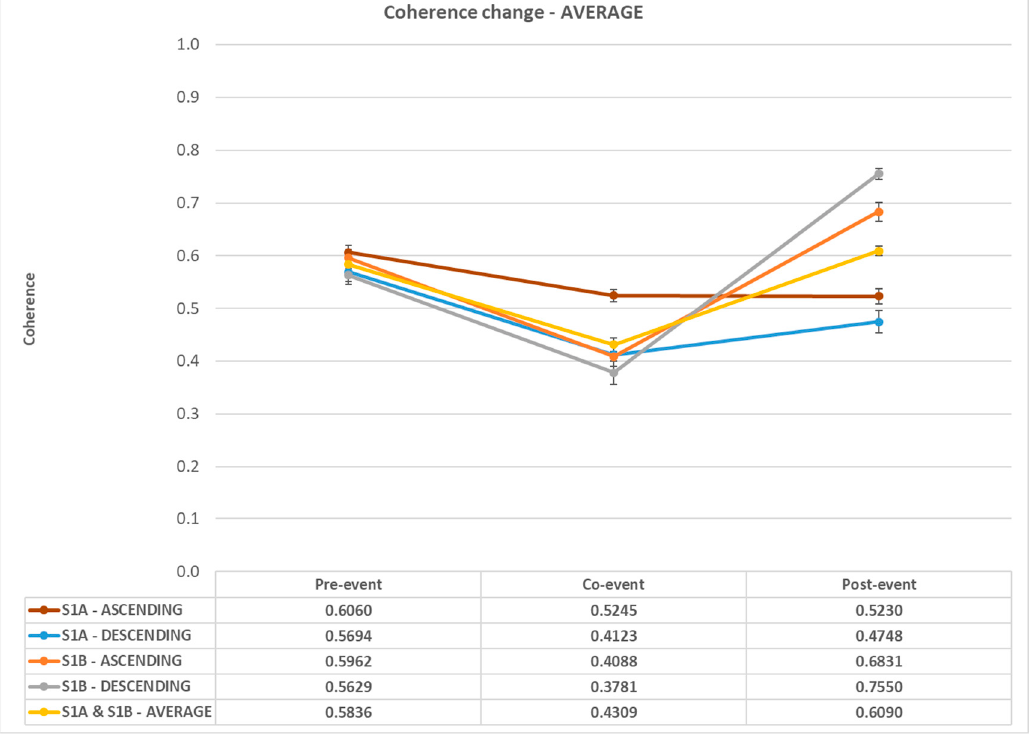
Figure 13. Average coherence changes in the wider area of rehabilitation works.